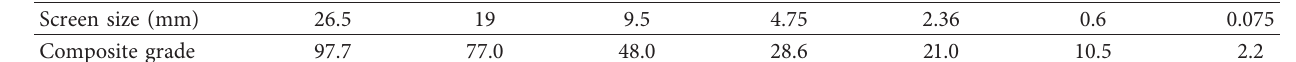
Table 2: Composite grade of concrete aggregate.